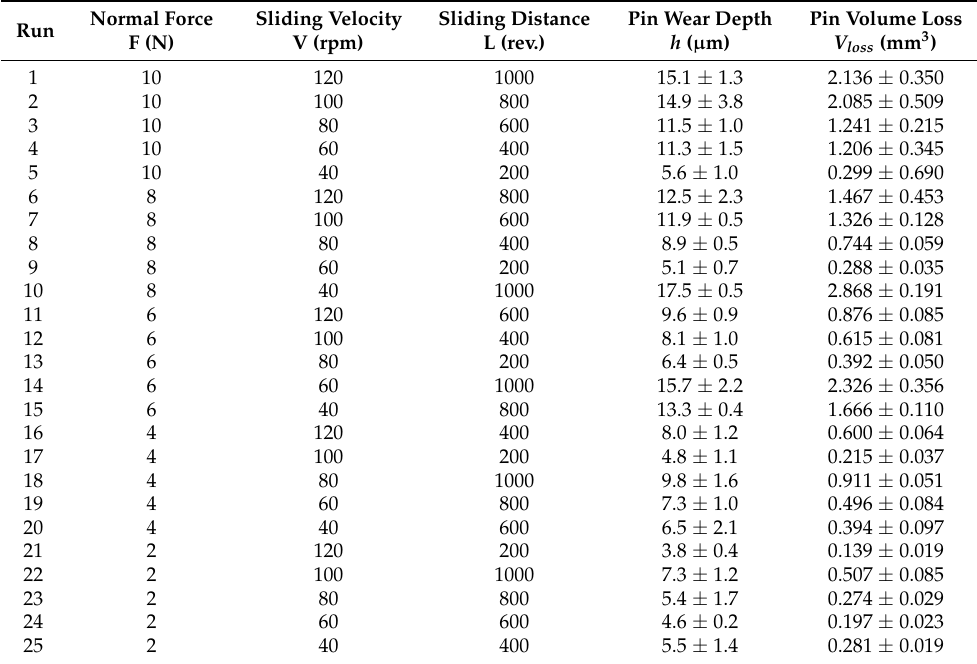
Table 4. Taguchi orthogonal array L 25 (5 3 ) and pin-on-disk test results in design